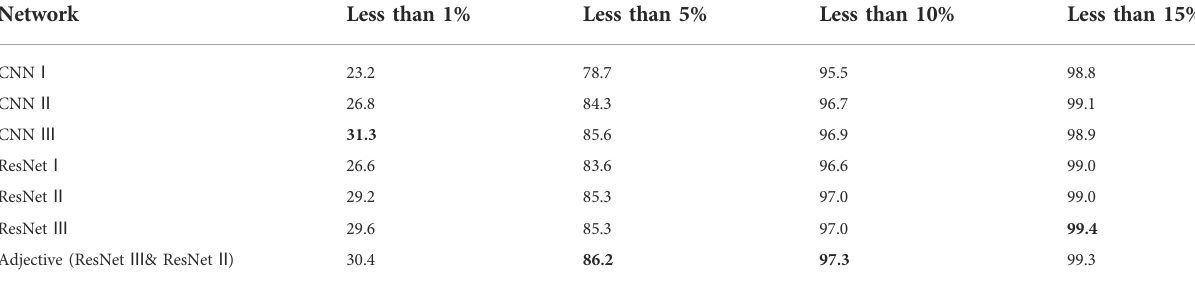
The best results under each error level are shown in